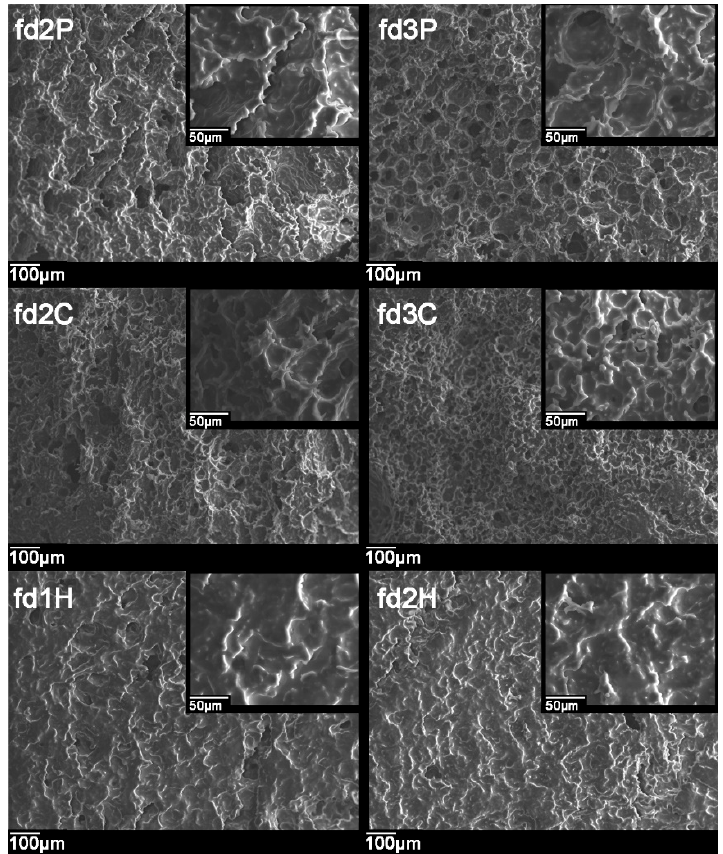
Figure 2. Cross-sectional micrographs of the freeze-dried systems obtained by scanning electron microscopy (SEM) at 100 and 500 times magnification.